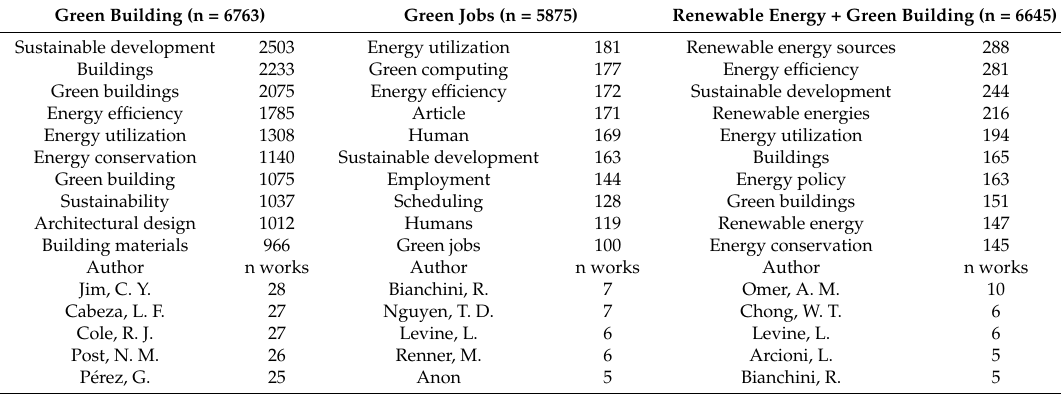
Table 3. Top ten key words and top five authors.